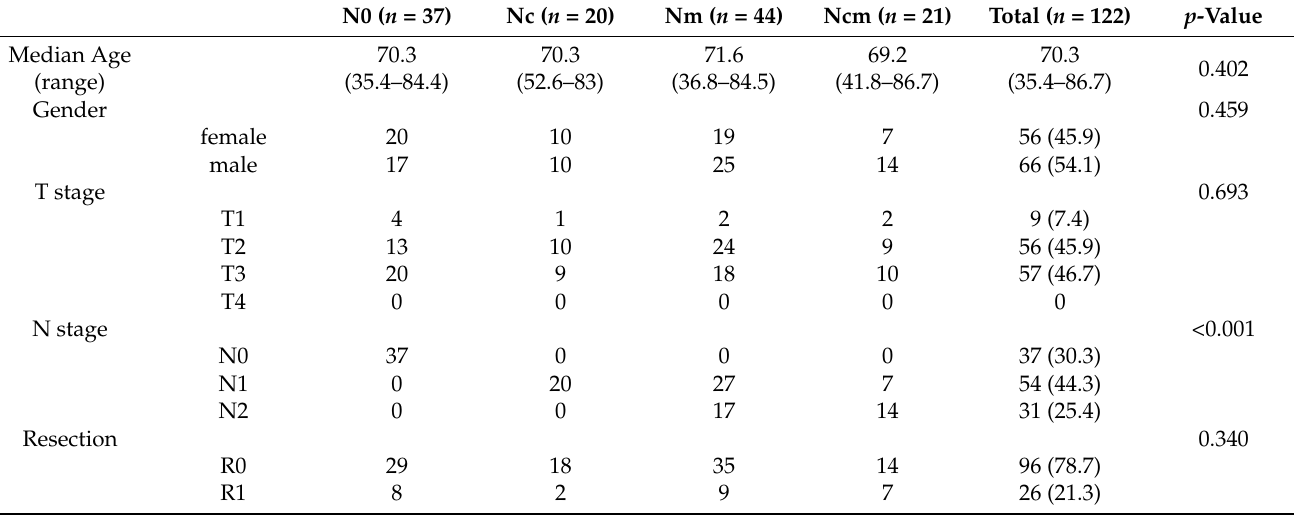
Table 1. Clinicopathologics arranged by the different lymph node